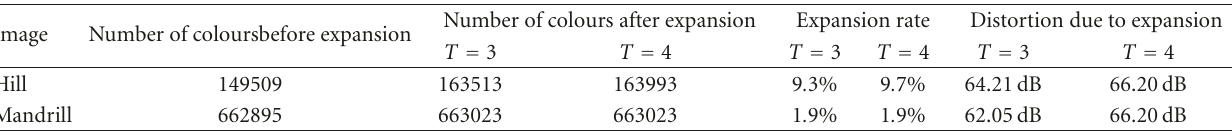
Table 1: The number of colours within the original and expanded colour tables with di ff erent threshold T . Note that “Distortion due to expansion” is the distortion incurred after one virtual colour is assigned to one pixel in the original image.